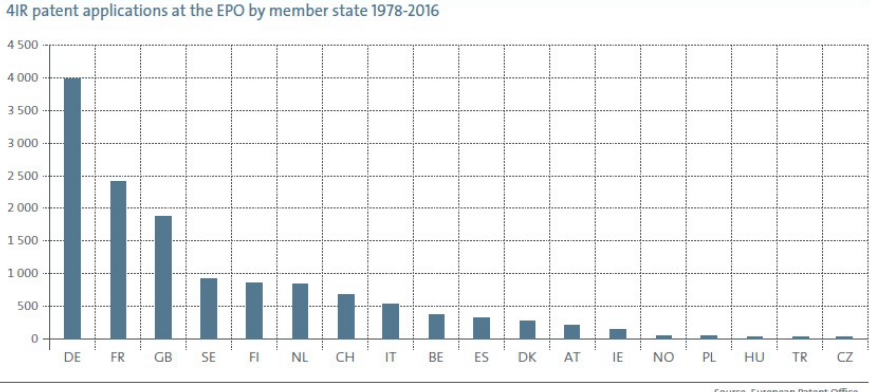
Figure 1. Number of 4IR patent applications at the EPO by member states during the period 1978–2016.